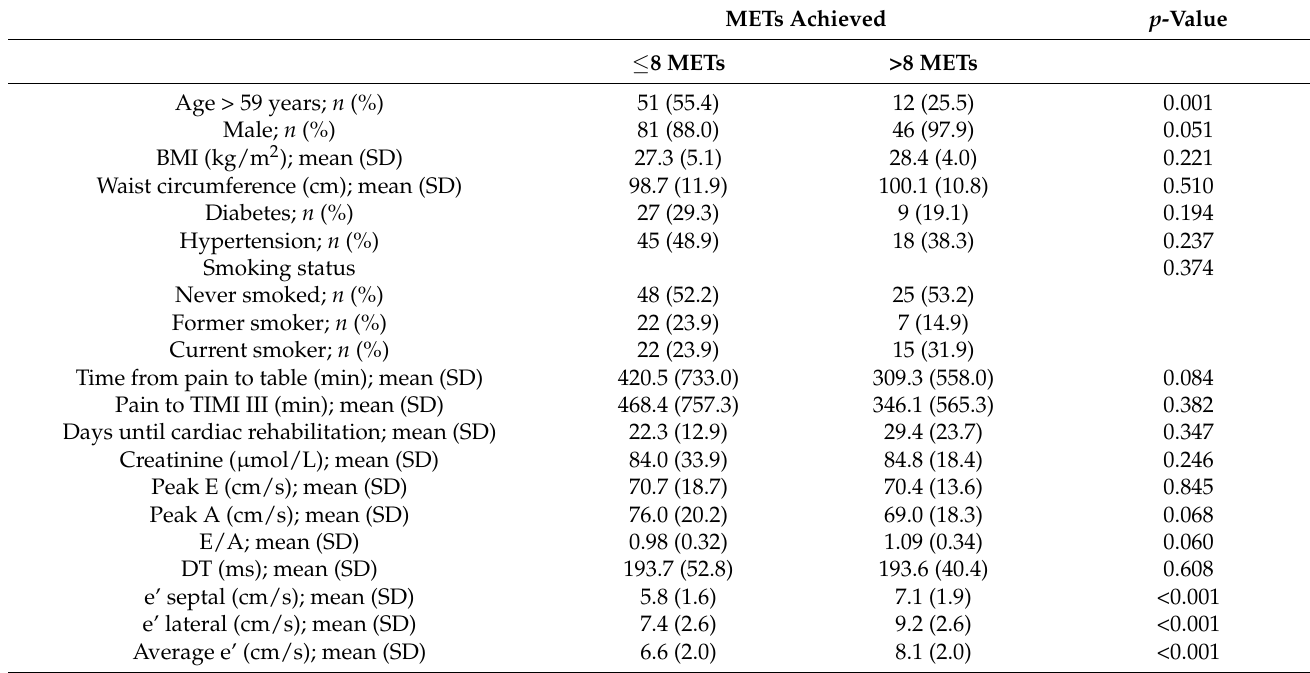
Table 2. Baseline variables of interest by METs achieved in a univariate logistic regression. METs Achieved p